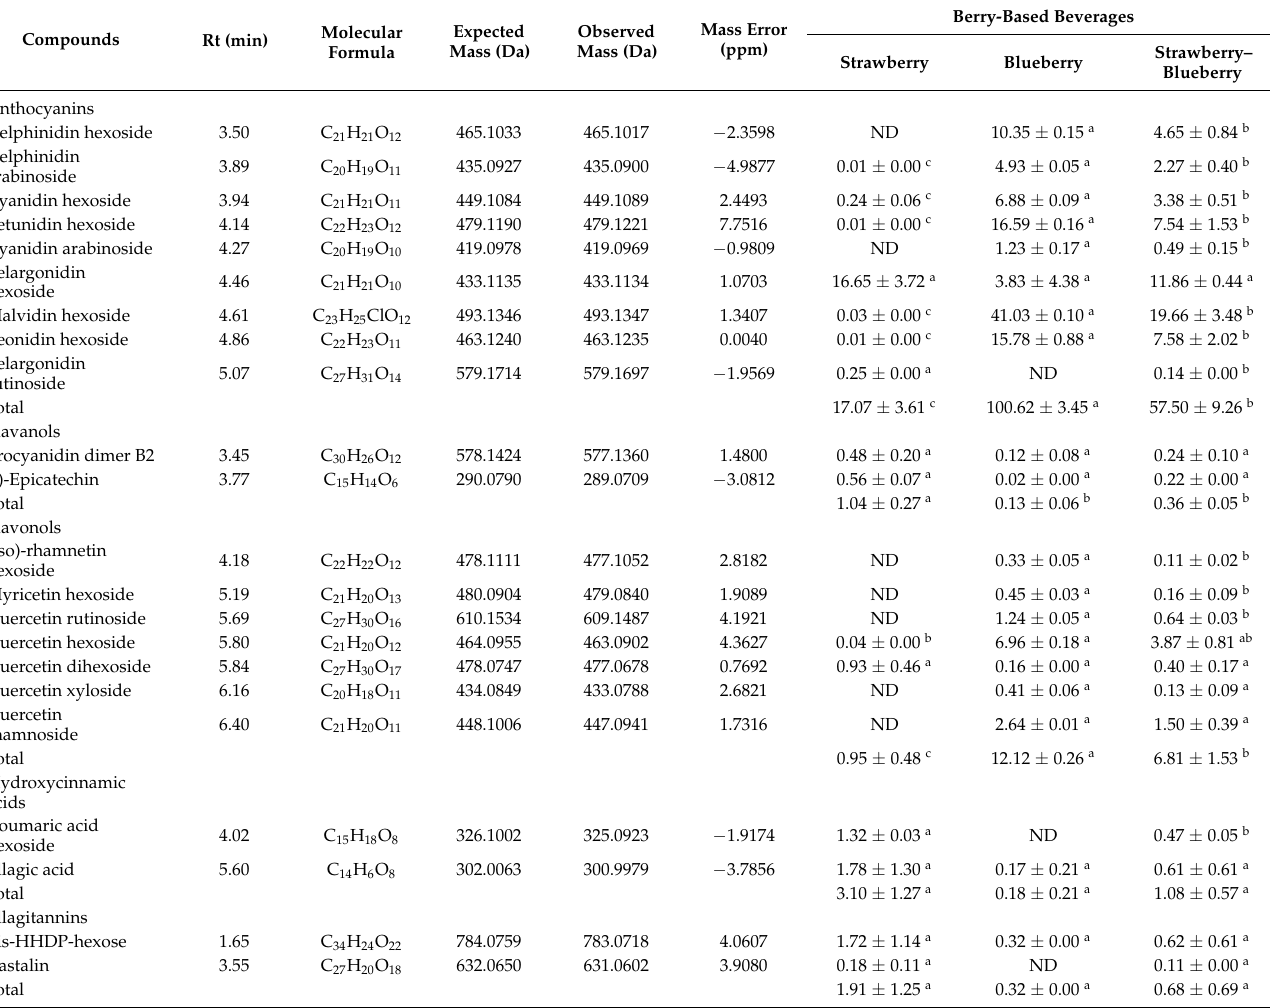
Table 1. Identification of polyphenolic compounds of strawberry, blueberry, and strawberry– blueberry beverages by